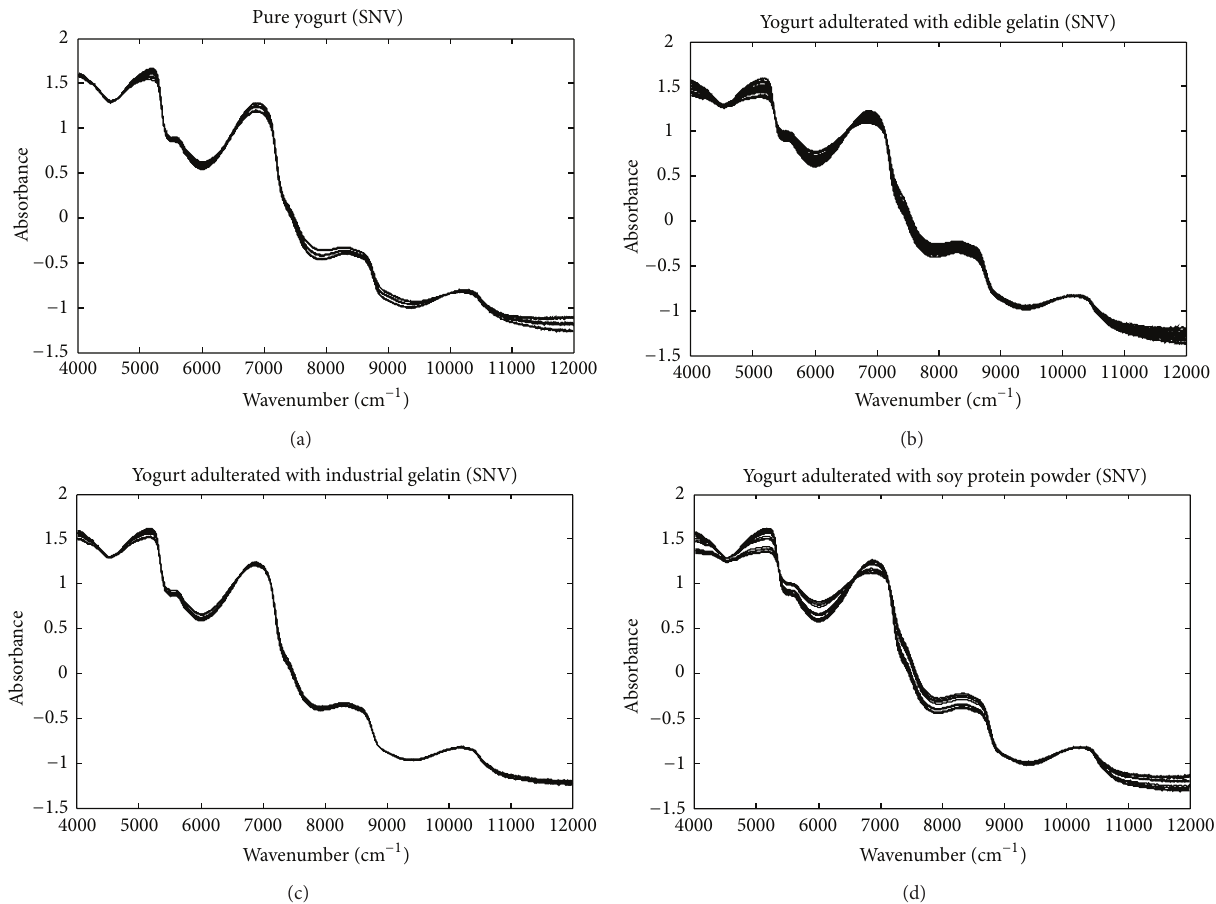
Figure 3: Typical SNV-transformed NIR spectra of yogurt objects adulterated with different levels of edible gelatin, industrial gelatin, and soy protein